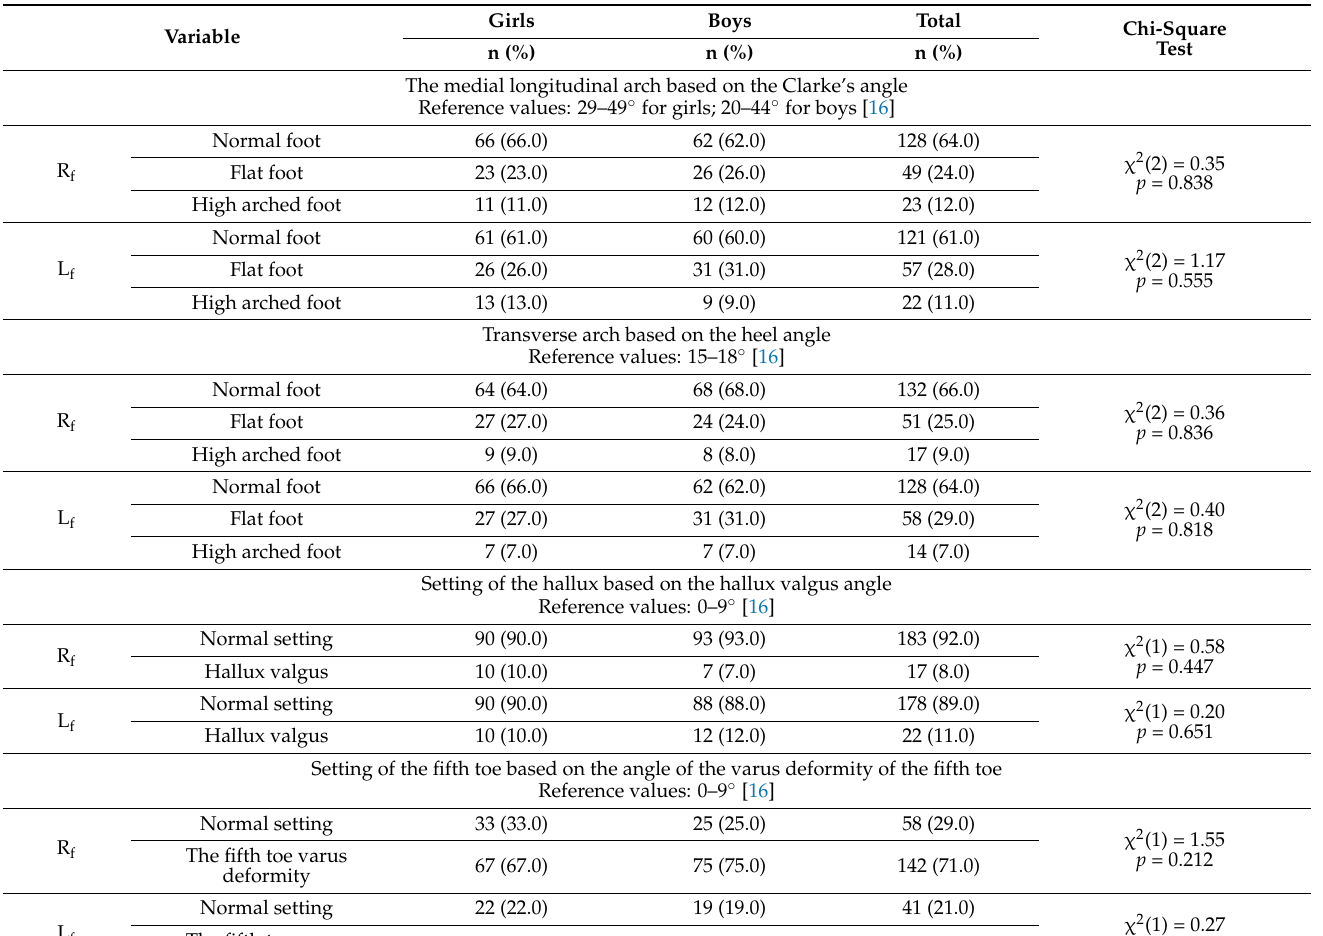
Table 5. The frequency of occurrence of foot deformities of the examined girls and